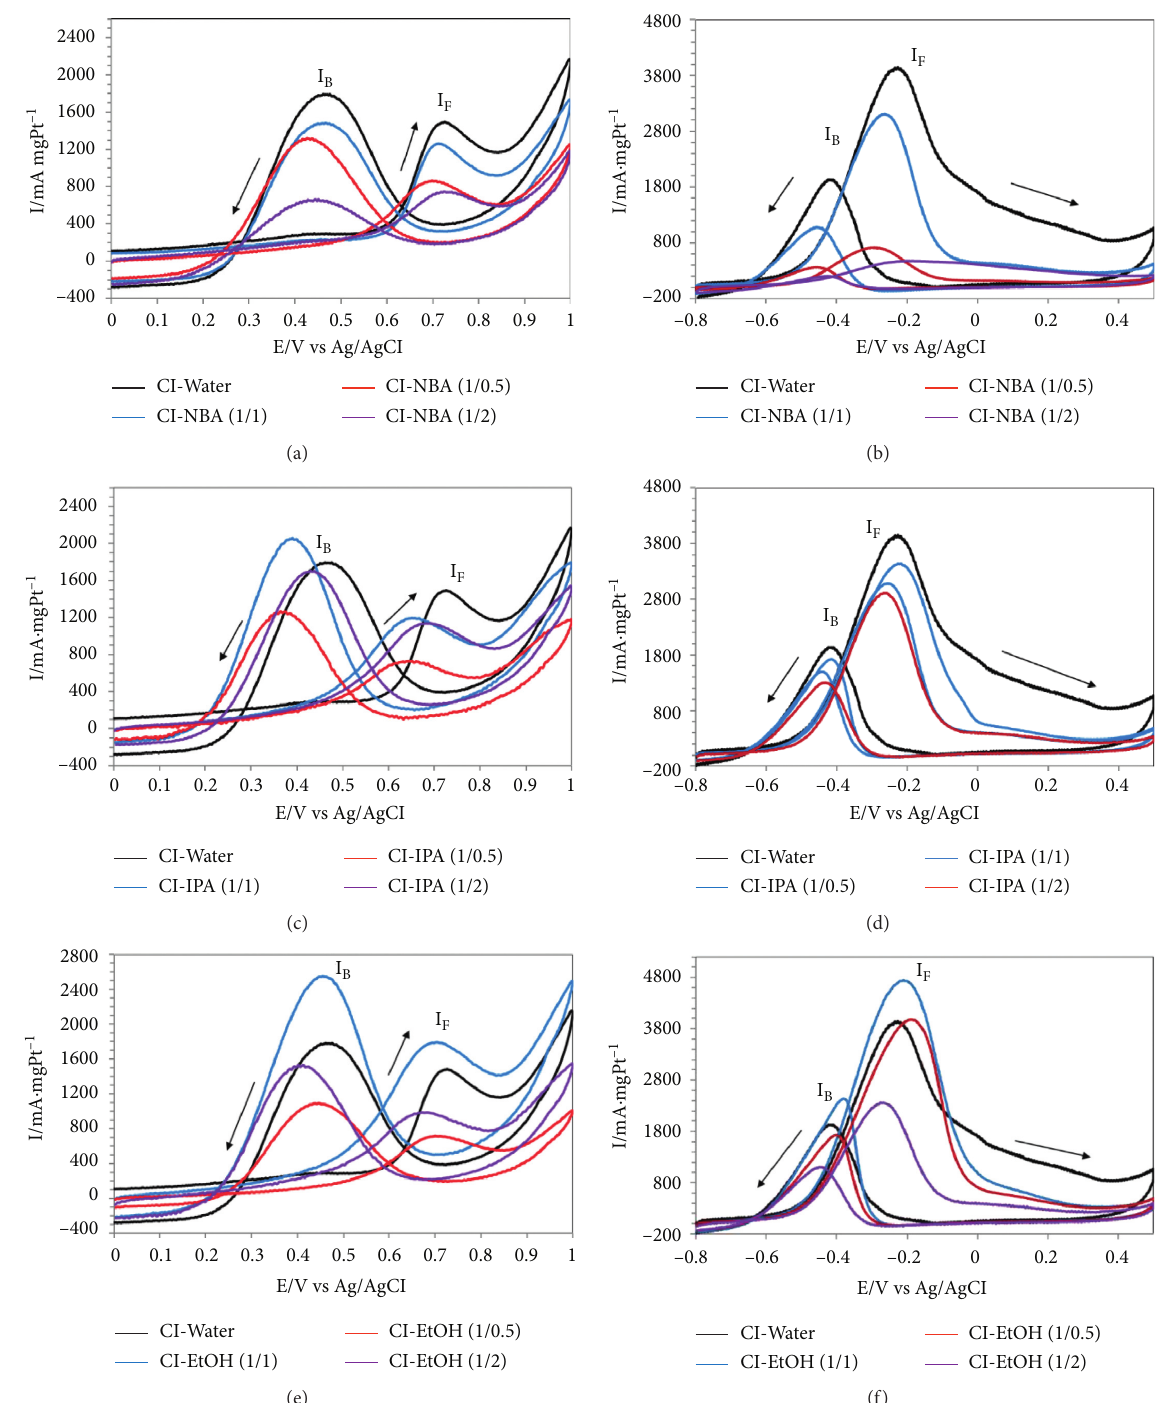
Figure 14: CV curves of (a), (b) CI-NBA, (c), (d) CI-IPA, and (e), (f) CI-EtOH catalyst inks in ethanol electrooxidation in acidic and alkaline medium. Acidic media: C 2 H 5 OH 1M+H 2 SO 4 0.5M. Alkaline media: C 2 H 5 OH 1M+NaOH 0.5M. Scan rate of 50mV s − 1 , ambient